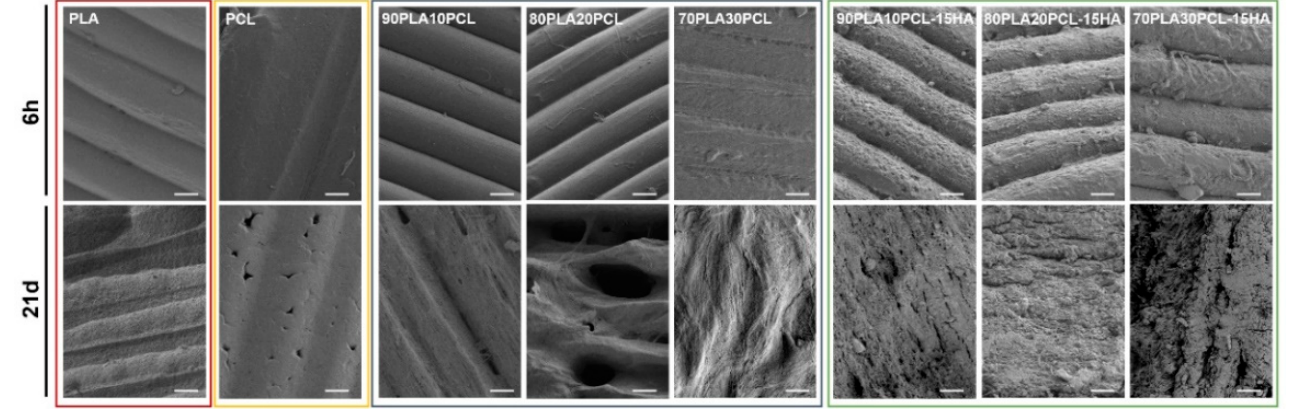
Figure 6. SEM images of the materials after 6 hours ( top row) and after 21 days ( bottom row) in degradation media 1M NaOH (scale bar: 50 µm).